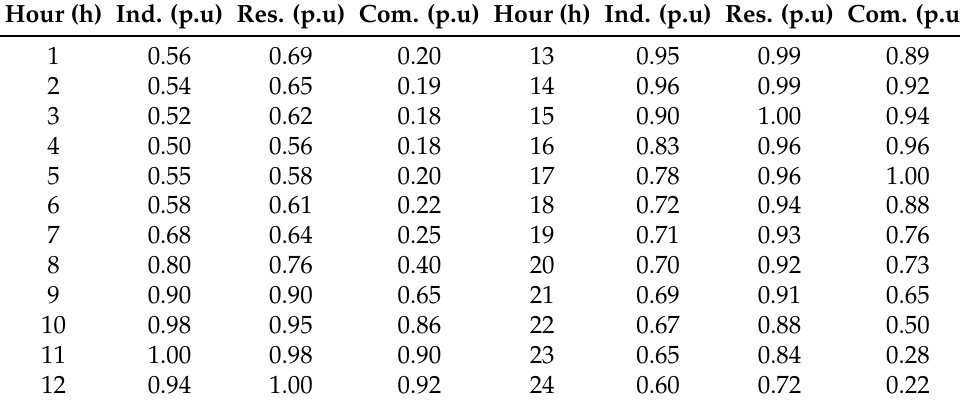
Table 2. Types of load profile.